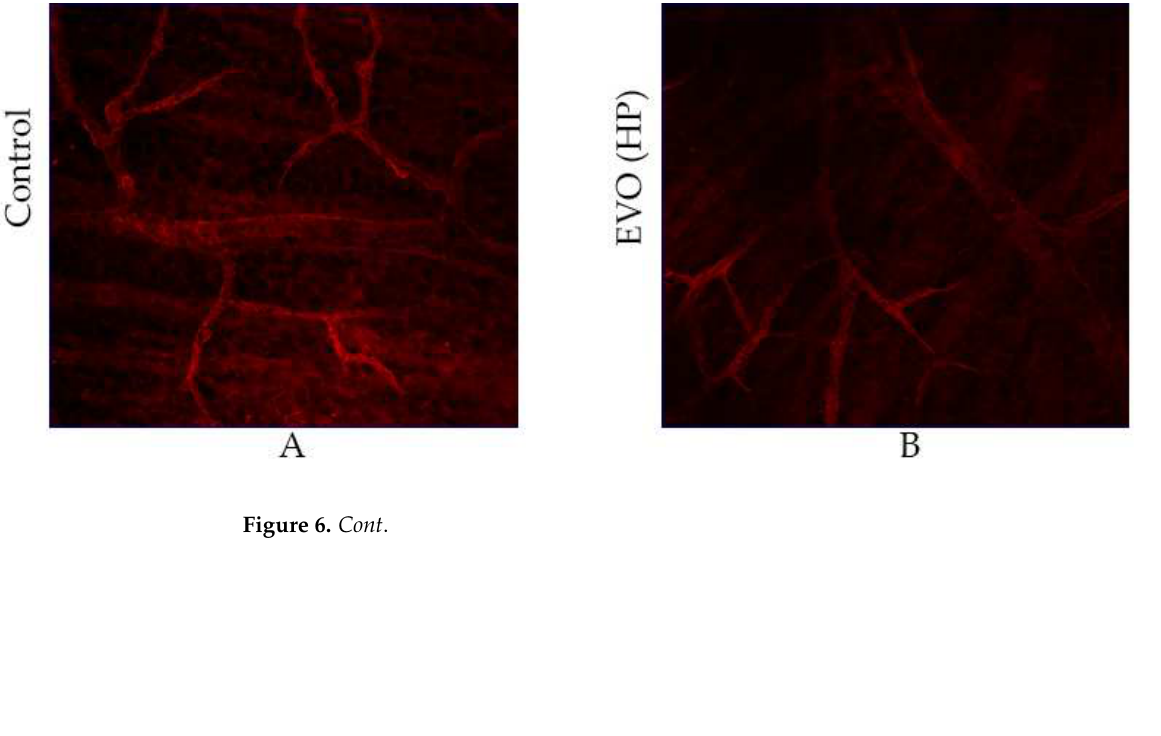
Figure 6. Immunostaining of anti-α-SMA and quantitative analysis of its fluorescence intensity in retinal flatmounts. The immunostained retinal flatmounts from the control group ( A ), the EVO (HP) group ( B ), and the EVO (RP) group ( C ). The staining intensity comparison among three groups ( D ). EVO: episcleral vein occlusion; HP: high intraocular pressure; RP: recovered intraocular pressure. Control group refers to the sham group. Values are expressed as mean ± SEM (* p < 0.05; n = 6 per group, scale bar = 50 μm).